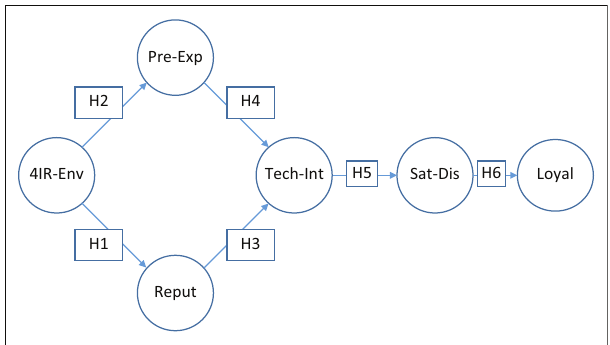
FIGURE 1: Proposed